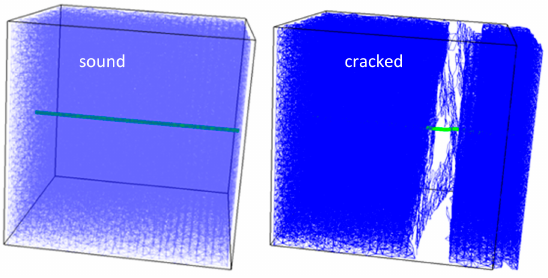
Figure 7. Lattice with an embedded tubular capsule.